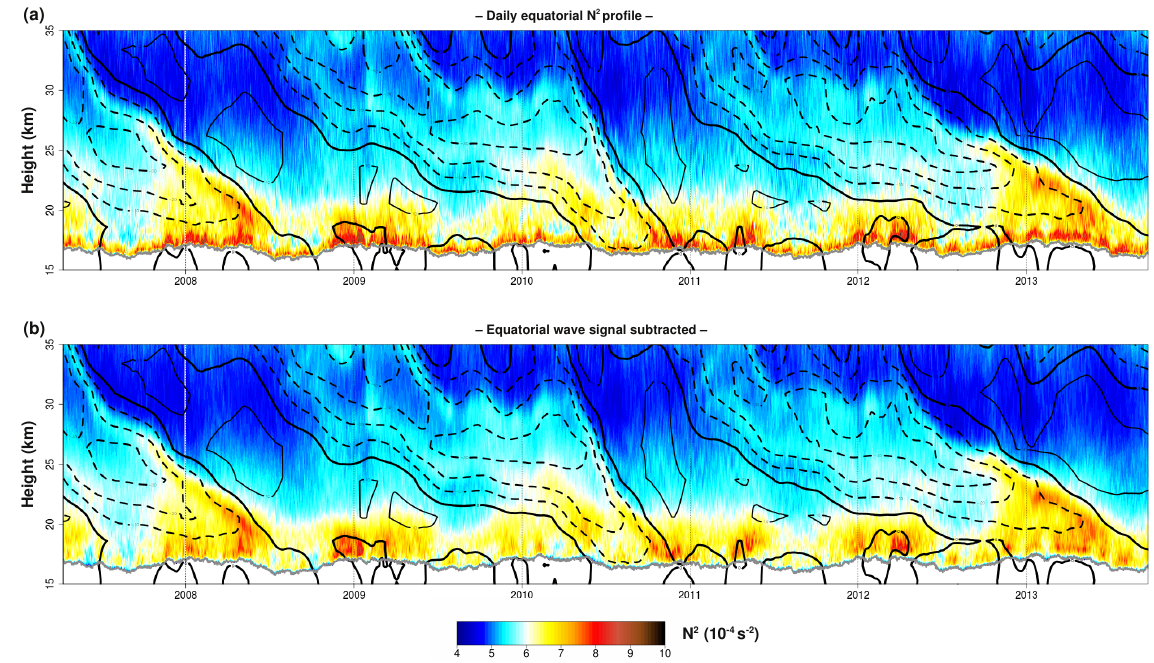
Figure 7. (a) Daily evolution of the tropopause-based, equatorial (10 ◦ S–10 ◦ N) zonal mean N 2 vertical profile between 2007 and 2013 (colors) from COSMIC GPS-RO profiles. The grey line denotes the tropopause height (TP z ). Thin black contours denote positive (westerly) mean zonal wind, with a thicker contour for the zero line, dashed contours for negative (easterly) winds and a 10ms − 1 separation. To improve visibility, the winds are displayed with a running mean of ± 15 days. No running mean is applied to the N 2 vertical profile or TP z in order to allow the subtraction of the equatorial wave signal. (b) Equatorial wave signal subtracted from the N 2 vertical profile.